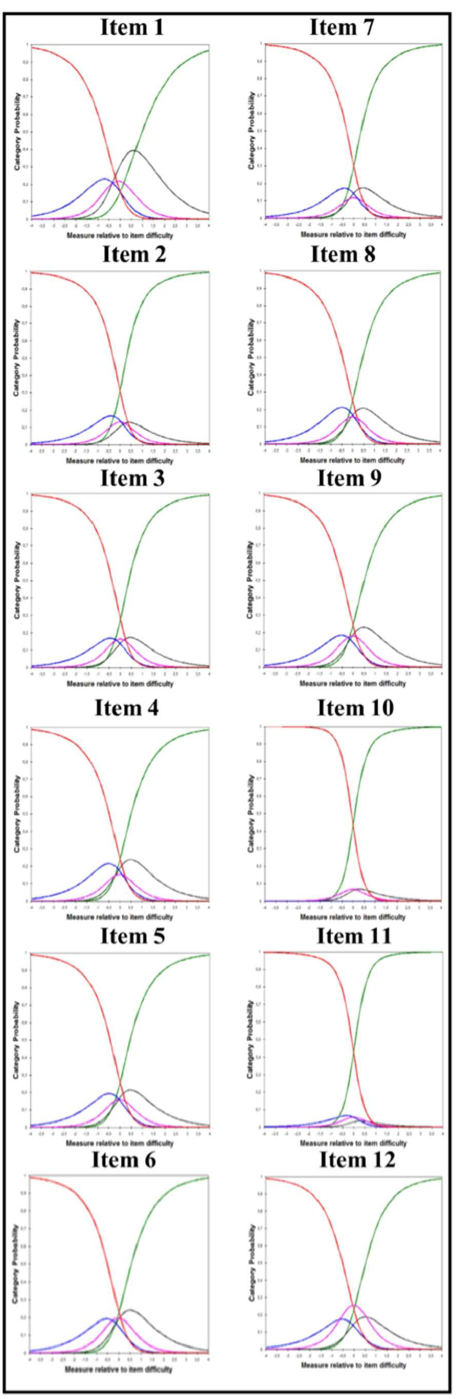
Figure 1. Item category curves (ICC) for the 12 items. All items showed disordered thresholds that suggested that the categories should be collapsed.